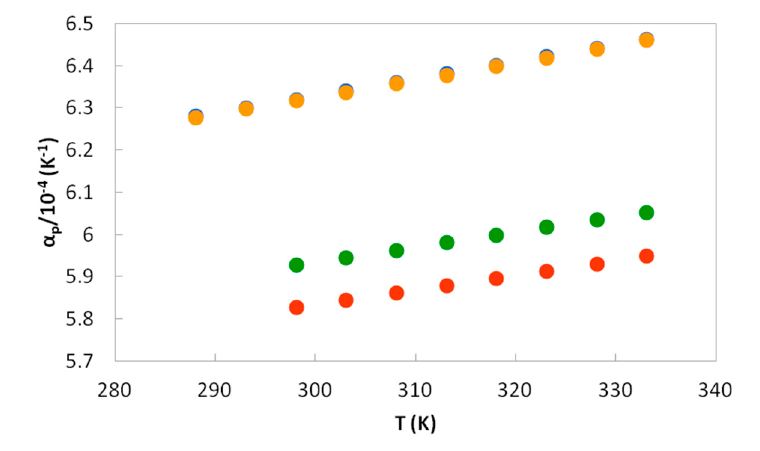
Figure 4. Coefficient of thermal expansion versus the temperature at 0.1 MPa, for dried ( ● ) and saturated ( ● ) [C 2 C 2 C 1 N][OTf] and dried ( ● ) and saturated ( ● ) [C 2 C 2 C 1 N][MeSO 3 ]